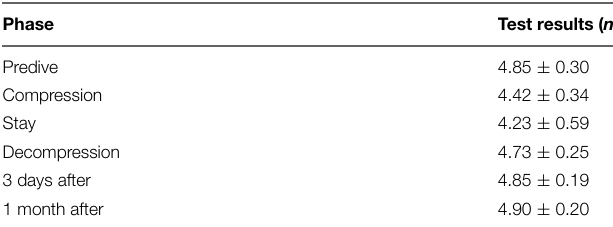
TABLE 3 | Spatial memory ability across different phases of the experiment ( ¯ X ± SD, n =